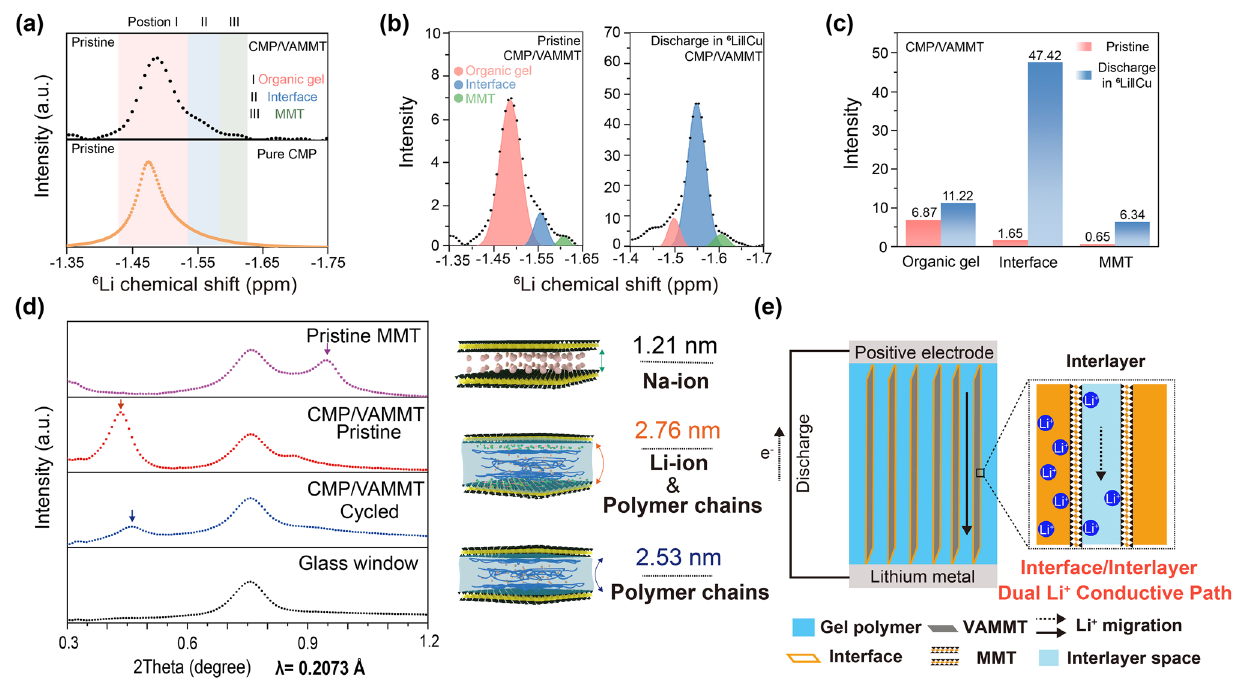
Fig. 4 Understanding the Li + migration mechanism in CMP/VAMMT. a 6 Li SSNMR spectra of pure CMP and CMP/VAMMT in the pristine state (the three-color zones represent the different chemical environments of Li ion in CMP/VAMMT, whereas in pure CMP only the chemical environments represented by red are present). b 6 Li SSNMR spectra of CMP/VAMMT before (left) and after (right) discharge in the 6 Li‖Cu cell. c Comparison of changes in different peak intensities in the Fig. 4b. d Synchrotron radiation X-ray diffraction (λ = 0.2073 Å) patterns of pristine MMT, pristine CMP/VAMMT, cycled CMP/VAMMT and the glass window (use for testing) (right: Schematics illustrating the layer spacing changes of MMT layers in pristine MMT, pristine CMP/VAMMT, cycled CMP/VAMMT from the result of the SRD pattern). e Schematic dia- gram of dual Li + migration path in the